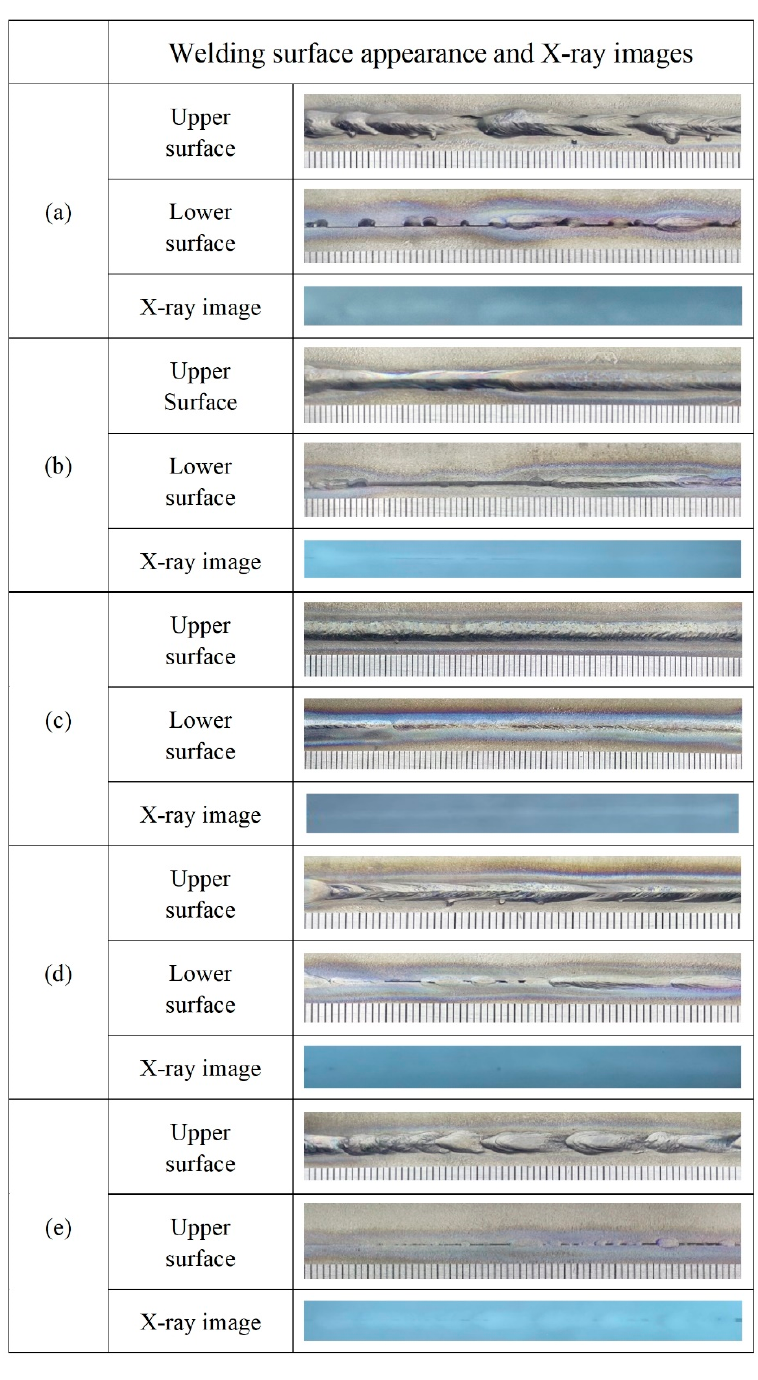
Figure 9. The welding surface appearance and X-ray images at different focal positions; ( a ) − 2mm; ( b ) − 1mm; ( c ) 0 mm; ( d ) +1 mm; ( e ) +2 mm.